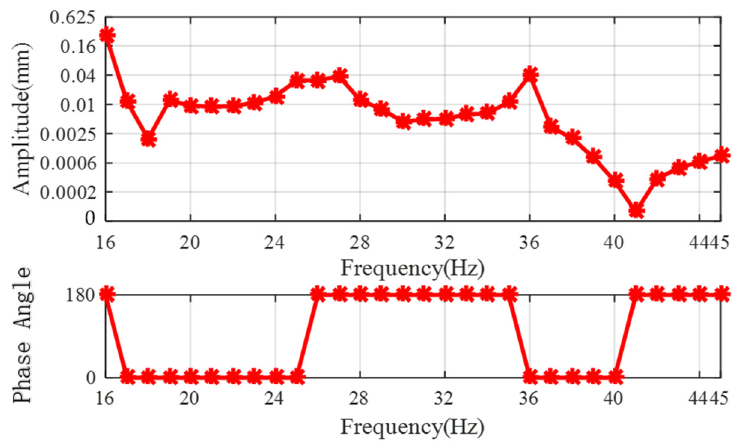
Figure 14. Amplitude response curve of the terminal surface after excitation optimization.